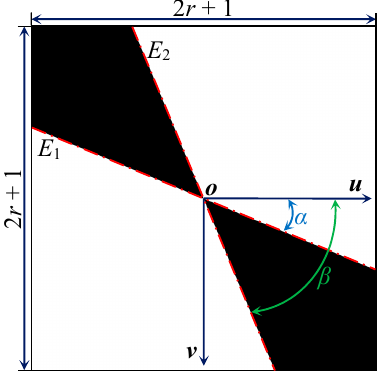
Figure 1. Definition of a chessboard image.